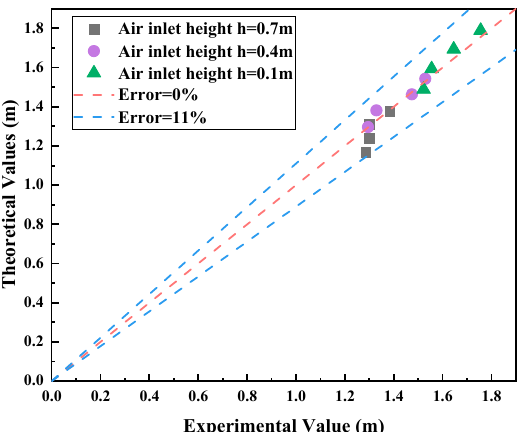
Figure 13. Comparison of predicted and experimental values of smoke layer height under different supply air volume conditions.